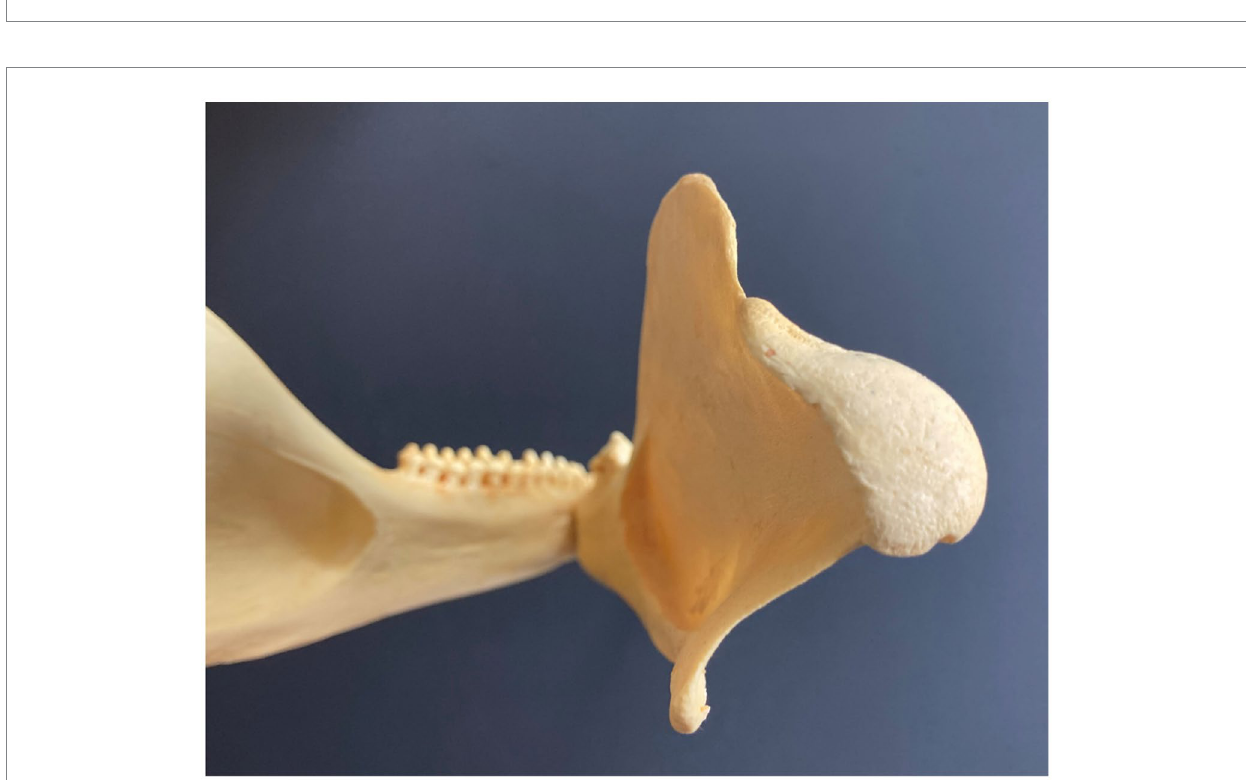
FIGURE 5 Mandibular condyle (posterior view) in Amazon river dolphin or boto, Inia